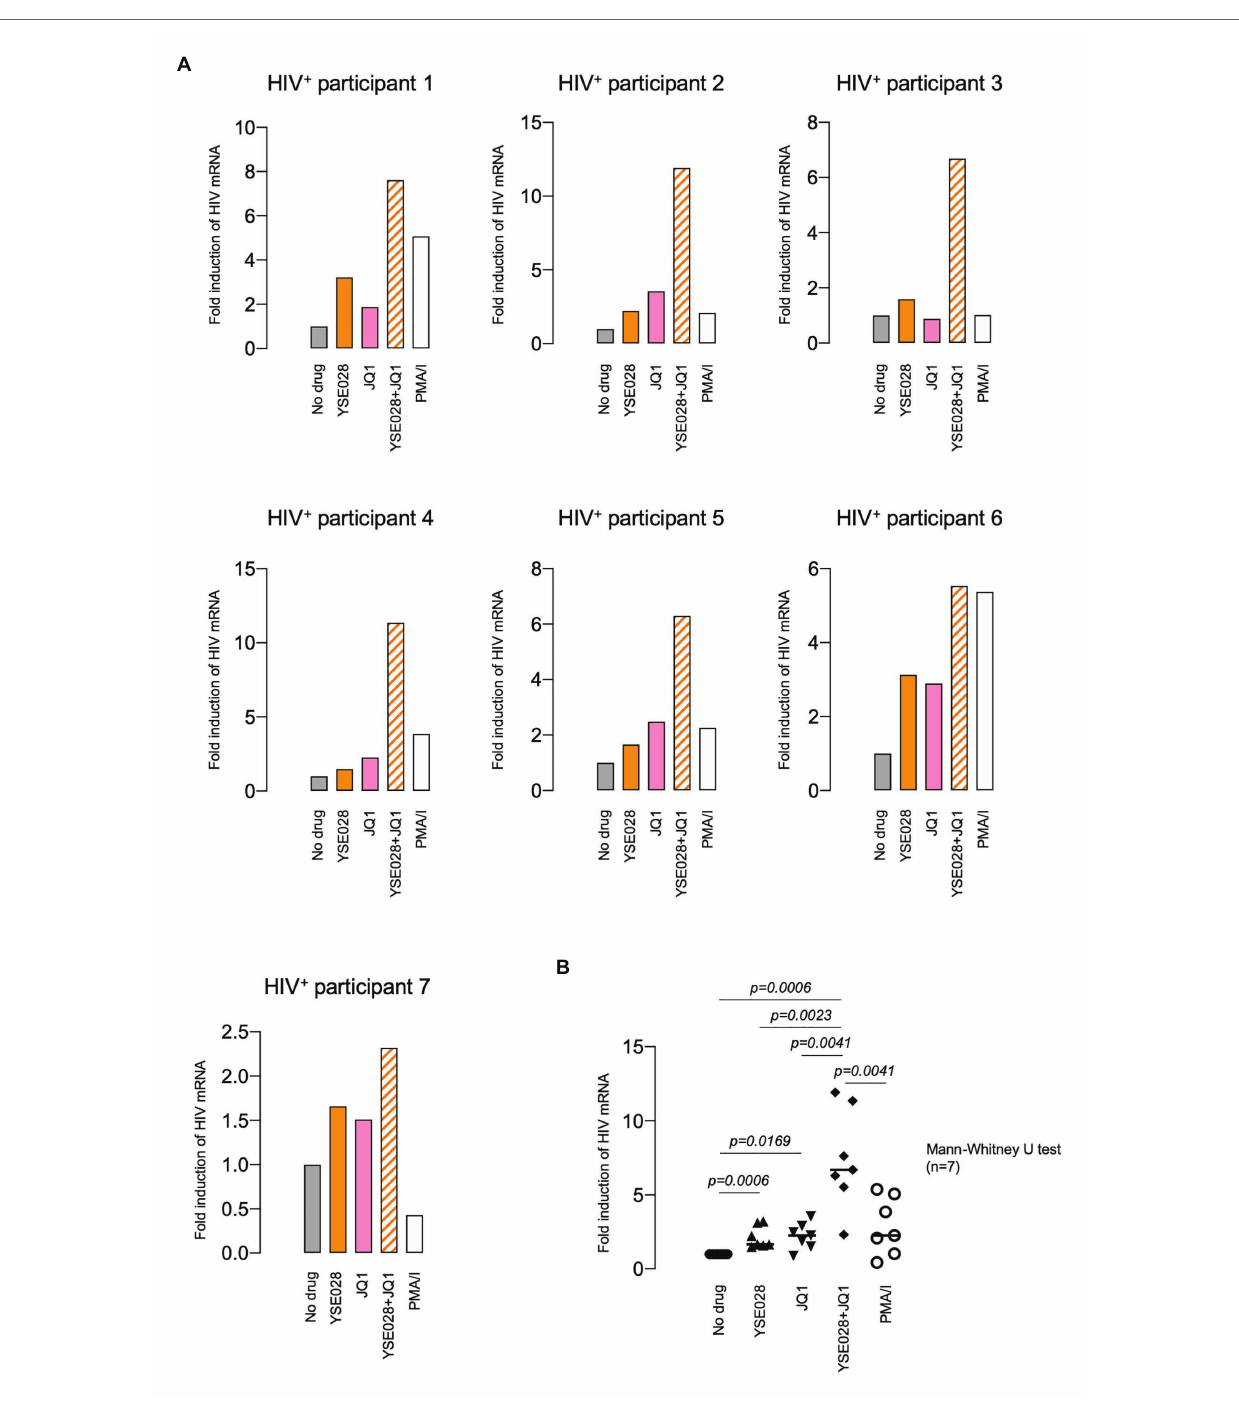
FIGURE 3 | YSE028 reactivates HIV-1 in CD4 + T cells from HIV-1-infected individuals. (A) Human CD4 + T cells purified from seven HIV-1-infected individuals undergoing cART ( Table 1 ) were treated with 10 μ M YSE028, 1 μ M JQ1, a combination of YSE028 and JQ1, or 100 nM PMA plus 2 μ M ionomycin for 24 h. Intracellular HIV-1 mRNA levels were detected by quantitative real-time PCR (qRT-PCR) and compared to those in untreated controls. (B) Statistical significance was determined using a Mann-Whitney U test, where a value of p < 0.05 was considered to be